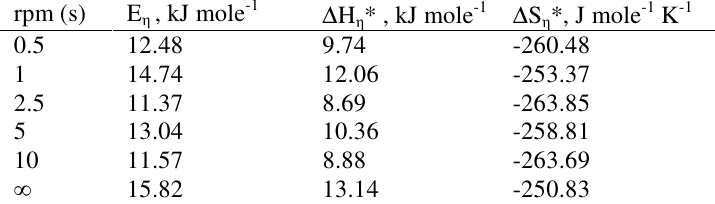
Table 2. Thermodynamic parameters (E different rpm(s).